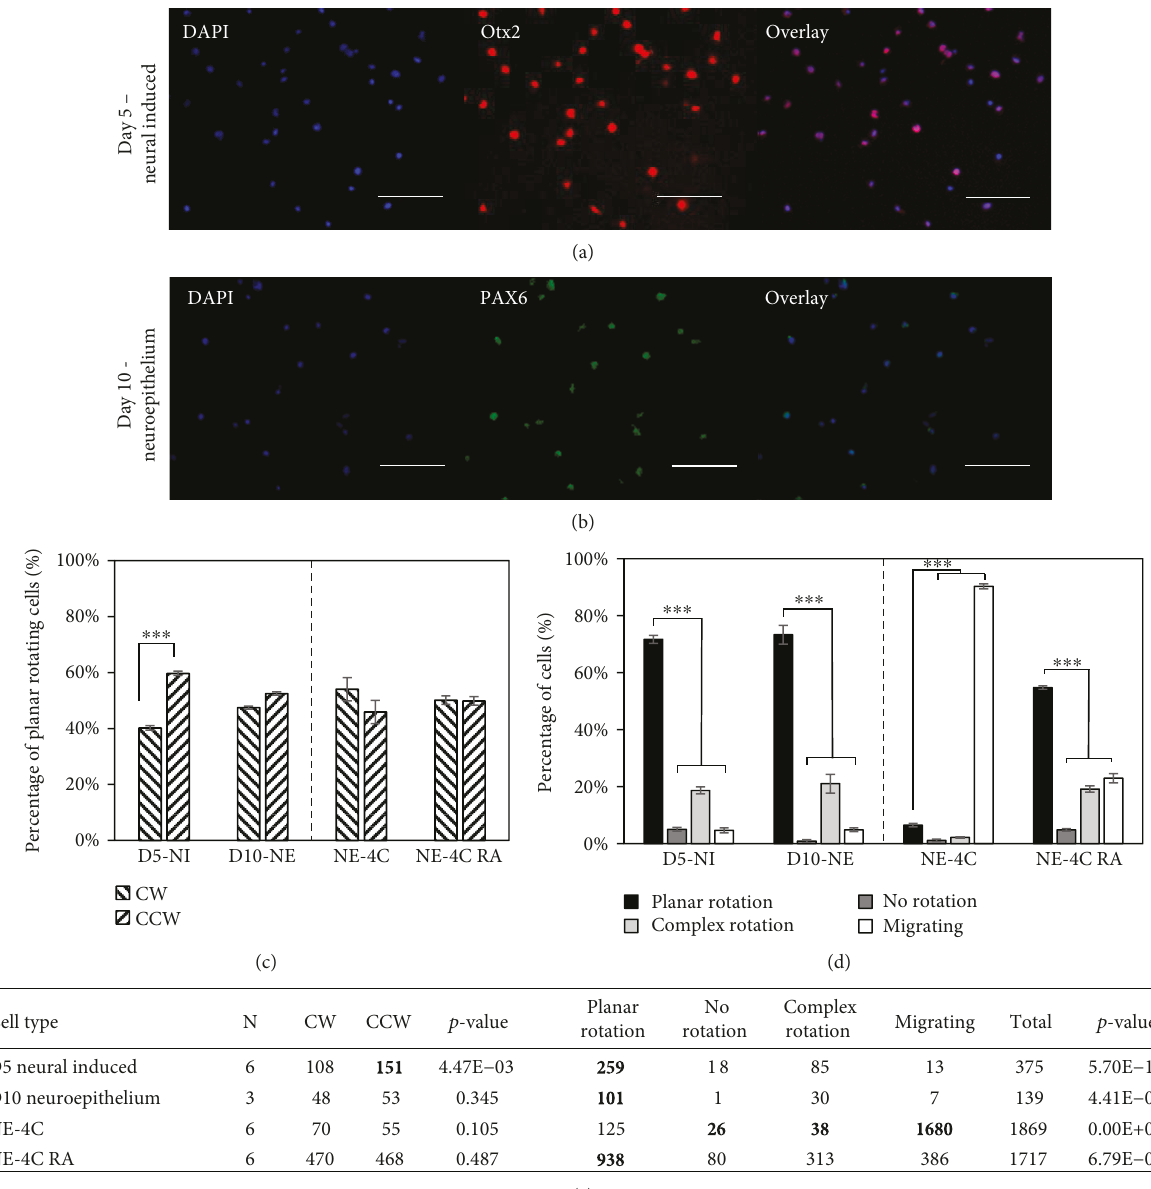
Figure 4: The intermediate neural di ff erentiation stage displays a CCW rotation bias, while neuroepithelium does not. (a) Day 5 neural- induced cells expressing Otx2, a neural ectoderm marker. (b) Day 10 neuroepithelium expressing PAX6, a neural lineage marker. (c) Neural-induced cells (D5-NI) show a statistically signi fi cant CCW rotational bias while neuroepithelium (D10-NE) and the neuroepithelial cell line NE-4C, both treated with retinoic acid (NE-4C RA) and untreated (NE-4C), do not. (d) All groups show signi fi cantly more planar rotating cells than other categories, except the NE-4C group which is mostly migratory. (e) Quantitative data showing the total number of cells in each category along with the number of replicate experiments ( N ). The p values indicate comparisons between CW and CCW and between planar rotation and the other three categories. Scale bars: 100 μ m; ∗∗∗ p < 0 001